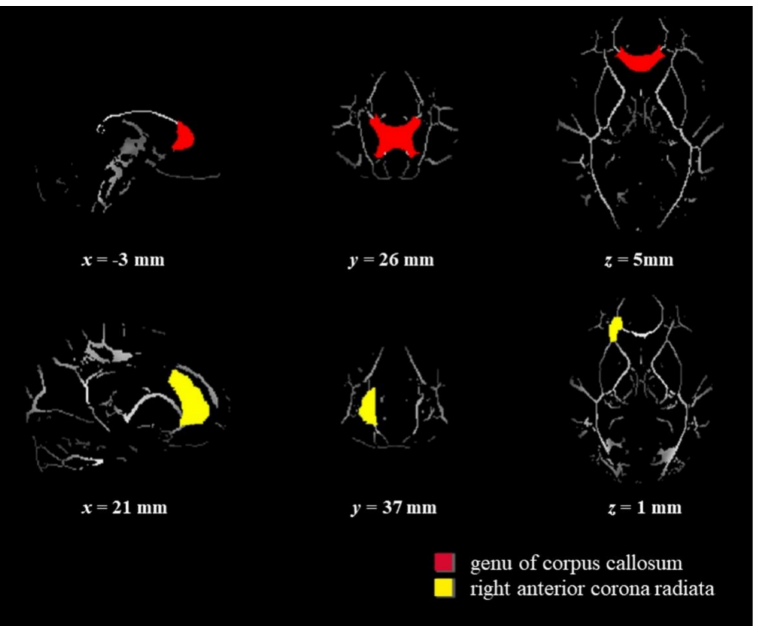
Figure 1. Brain regions with significant interaction effects on FA. Note: These are the sagittal, coronal, and horizontal views. The right hemisphere is on the left while the left hemisphere is on the right. Study-specific FA skeleton, representing the place of principal WM tracts, is shown in red and yellow, overlaid on the FMRIB58-FA-skeleton-1mm atlas